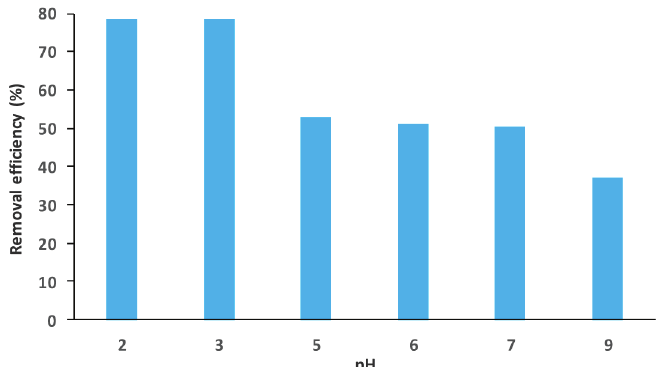
Fig. 5 – Effect of pH on Azo dye degradation by Mn, Mo, la/ TiO